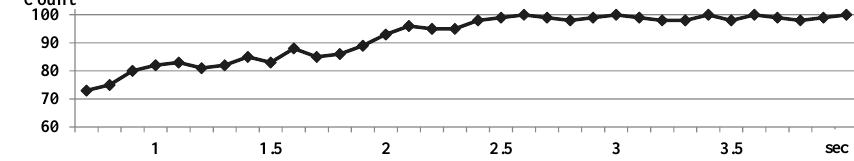
Fig. 4. Detection of high frequency pairs for identifying optimum m